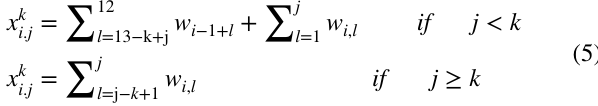
Table 3 Classification of different states of drought indices